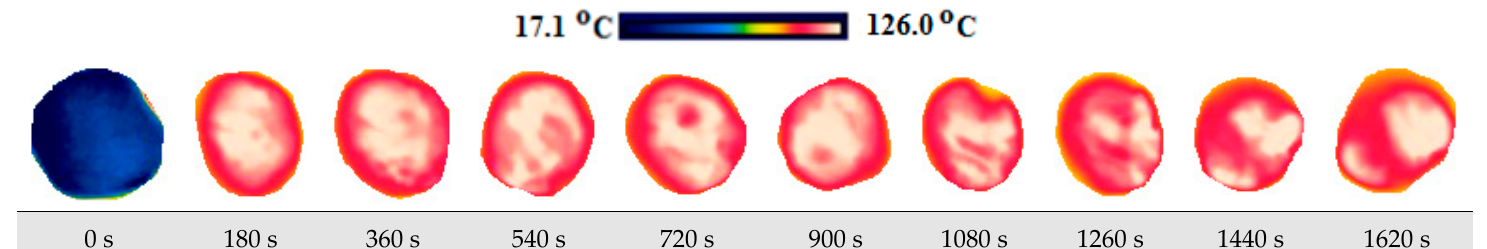
Figure 17. Thermal images of persimmon with 7 mm at 600 W.